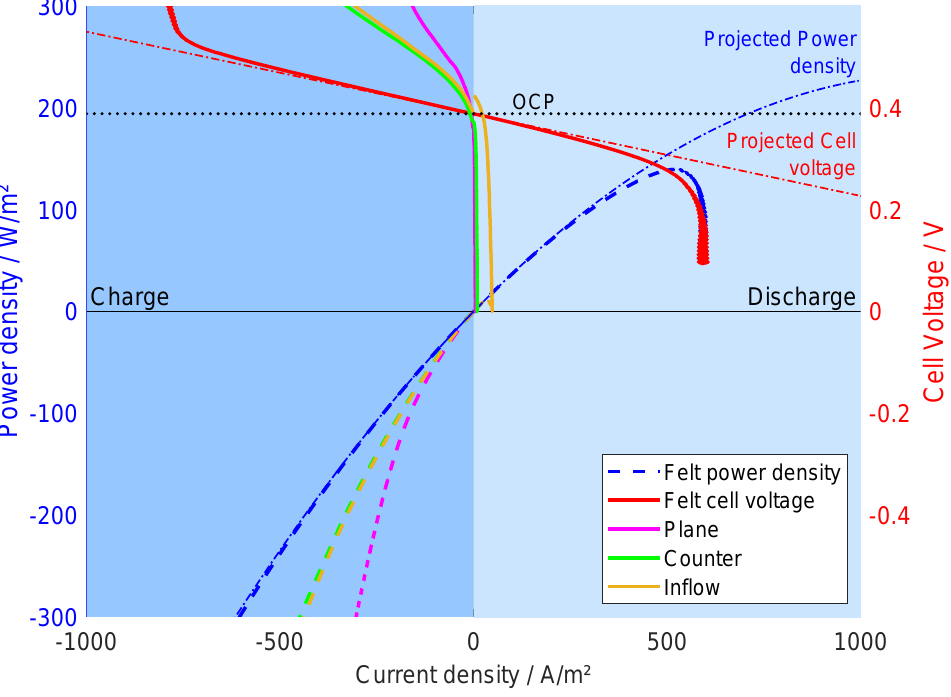
Figure 6. Power density in respect to current density and polarisation curve of the flow cell for the four electrode types. Negative current density values denote charging of the cell, positive current density values denote